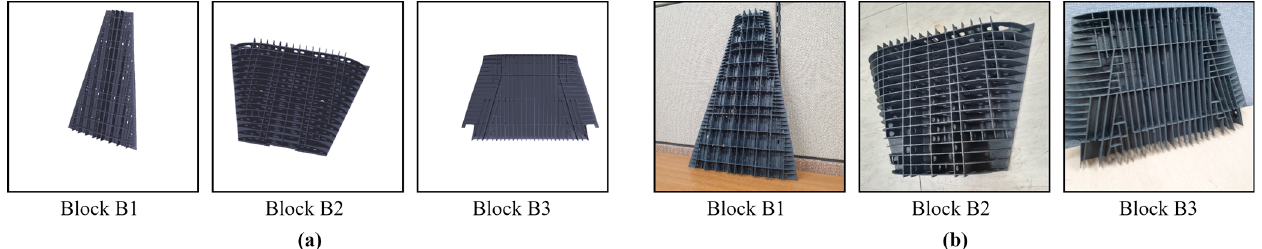
Figure 2. Block images from Non-Thr dataset: ( a ) Block images from Non-Thr training dataset consisting of multi-view images of hull block 3D CAD data; ( b ) Block images of Non-Thr testing dataset consisting of 3D printed model images of hull block 3D CAD data.